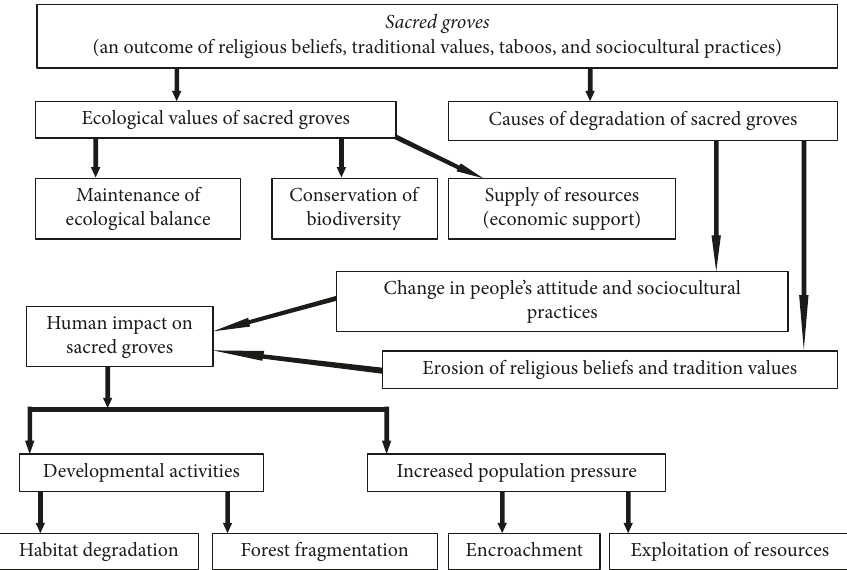
Figure 2: Relationships between ecological values, religious beliefs, and traditional values and causes of degradation of sacred groves (courtesy: